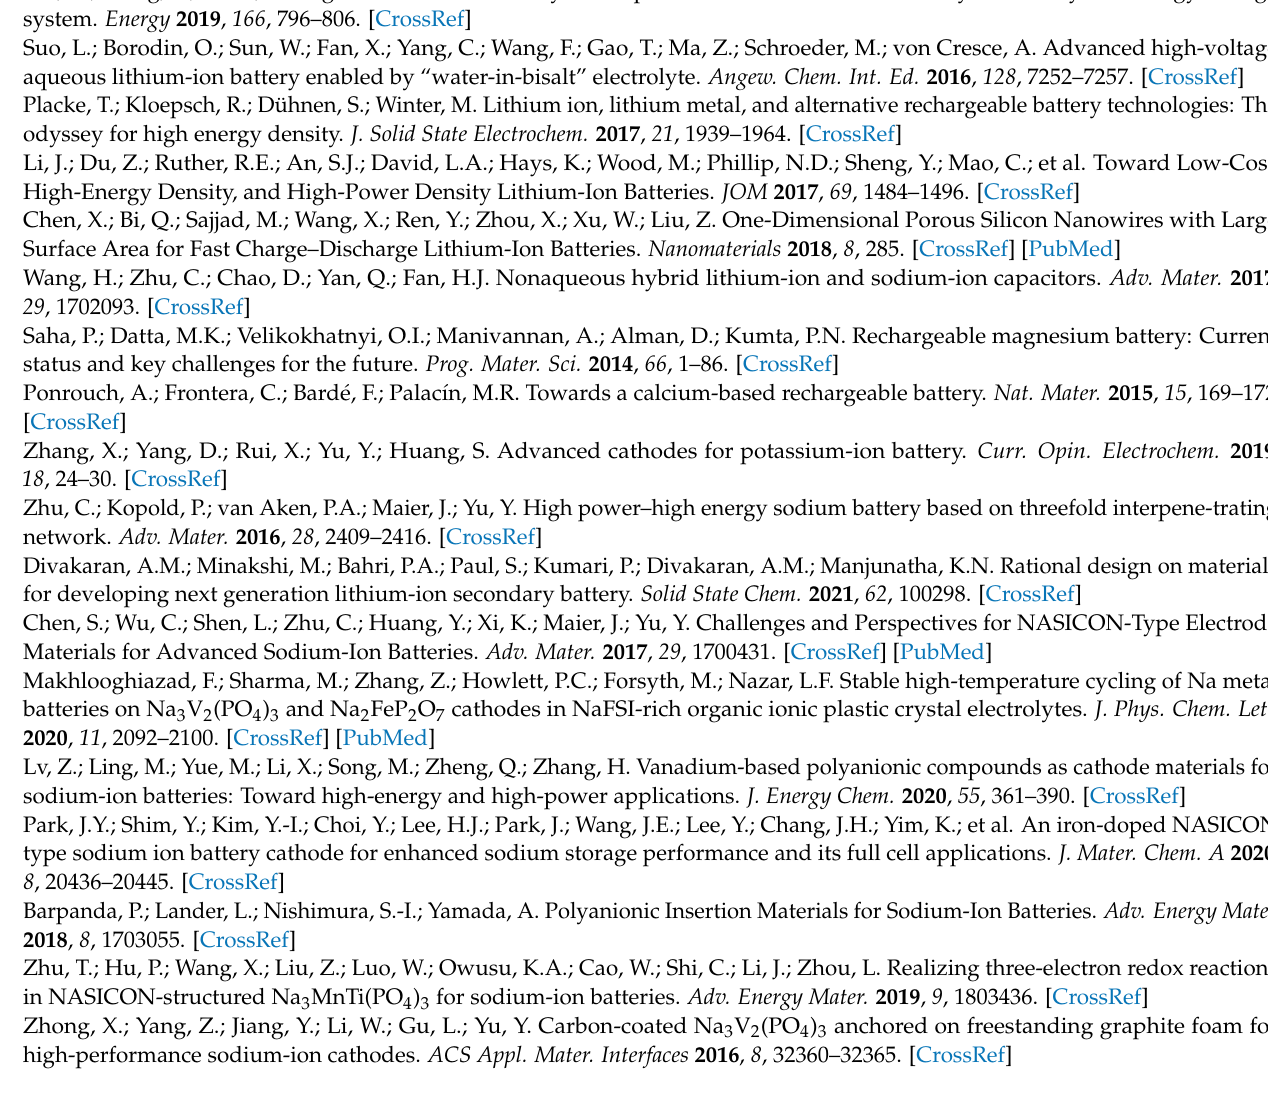
(b) Cycle life; Table S1: Lattice parameters of pristine NMCP and as-synthesis NMCP/rGO; Table S2: Summary BET data of the NMCP and NMCP/rGO samples; Table S3: Electrode kinetic parameters obtained from equivalent circuit fitting of EIS for NMCP and NMCP/rGO